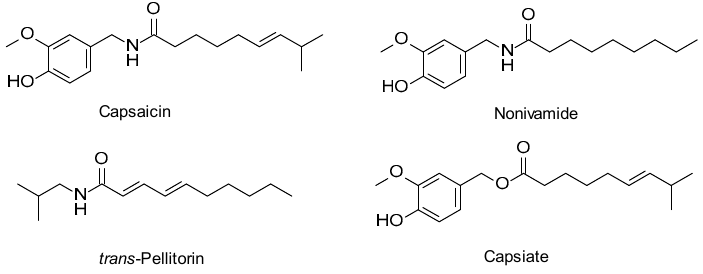
Figure 1. Structures of capsaicin, nonivamide, trans -pellitorine, and capsiate.